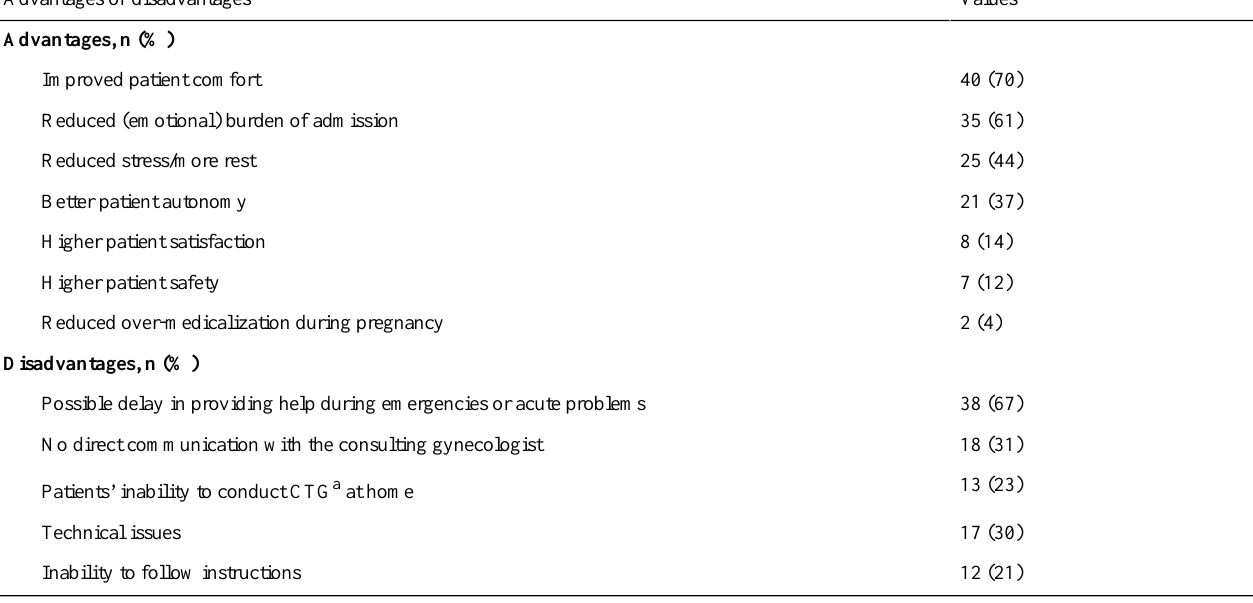
Table 3. Advantages and disadvantages of home-based monitoring and telemonitoring for patients according to the respondents (n=57). ValuesAdvantages or disadvantages Advantages, n